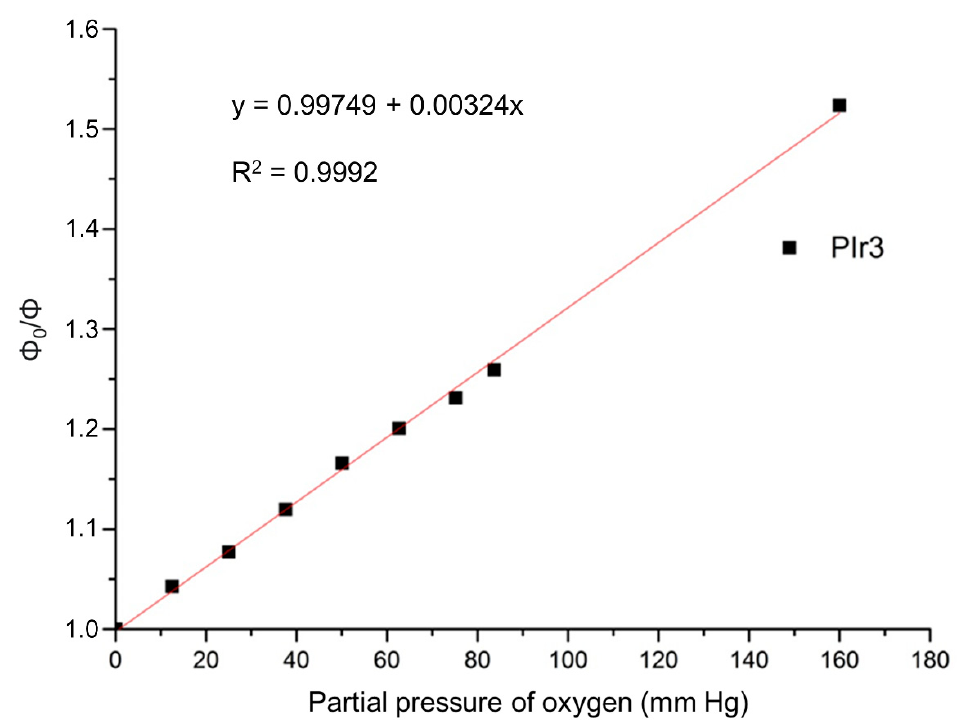
Figure 4. Stern–Volmer oxygen quenching plot for PIr3 in aqueous solution.